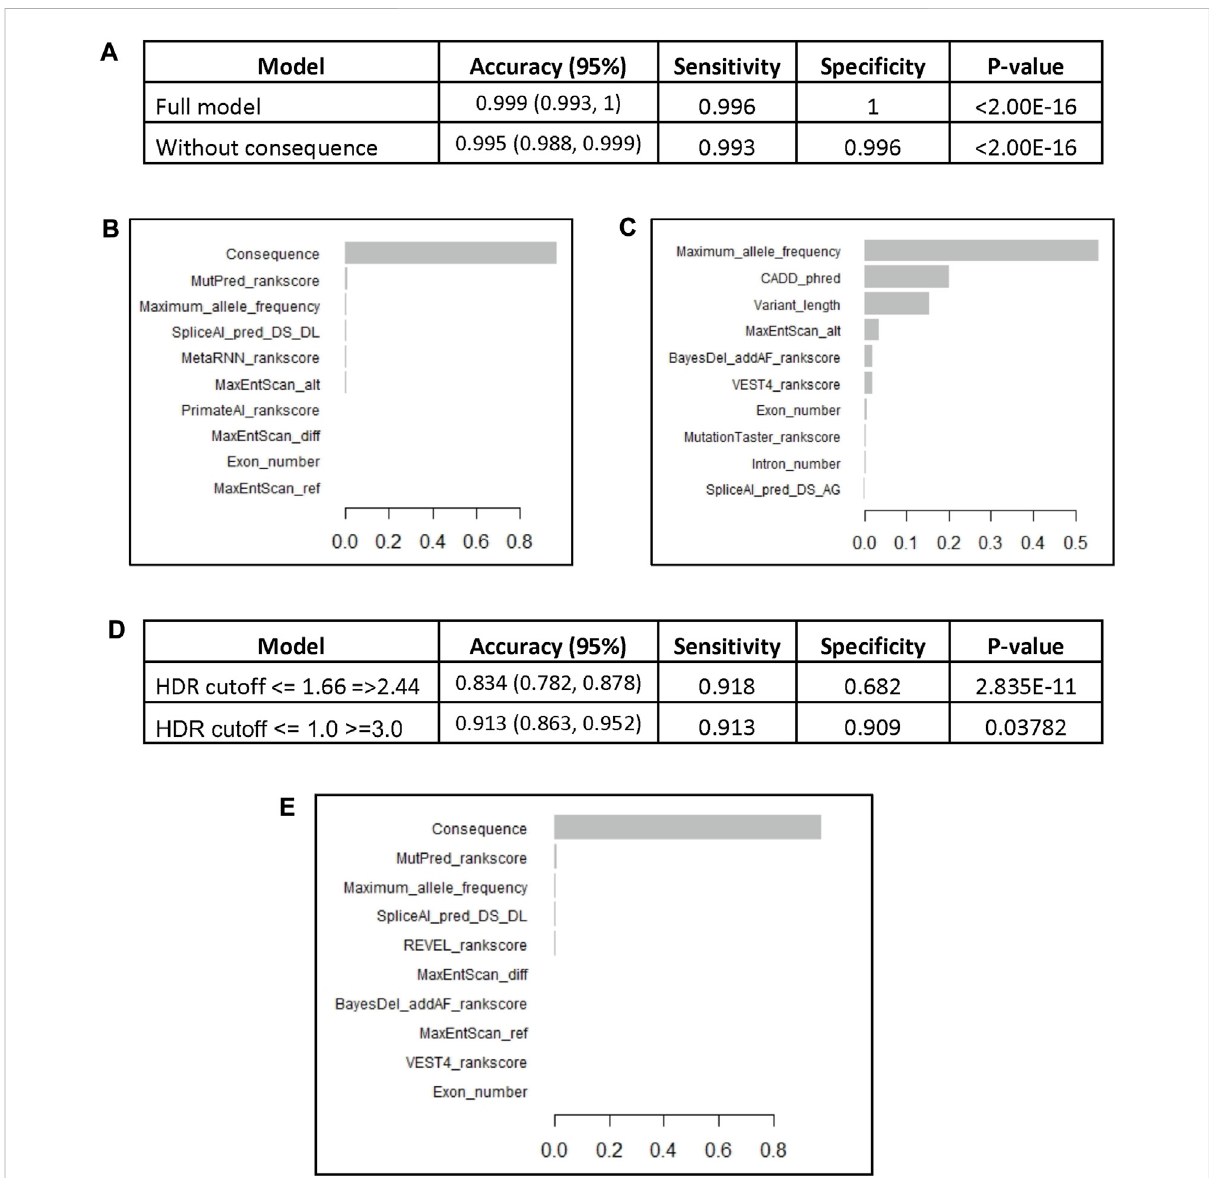
FIGURE 2 The BRCA2 XGBoost models. (A) The models characteristics (AUC: Area Under the Curve). (B) Feature importance of the XGBoost model. (C) FeatureimportanceoftheXGBoostmodelwithoutconsequence.TheBRCA2XGBoostmodeltrainedonthewholerevieweddataset(4,102variants) was used to predict VUS pathogenicity based on HDR functional assay scores. (D) The performance of the model on a set of pathogenic and benign variants according to HDR cutoffs < = 1.66 and = > 2.44 (247 variants) and cutoffs < = 1.0 and > =3.0 (160 variants). (E) Feature importance of the XGBoost model trained on the whole reviewed